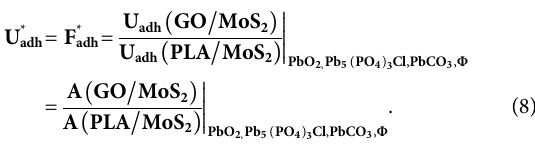
Figure 7 compiles the evolution of U adh* for the “ PbO 2 , Pb 5 (PO 4 ) 3 Cl, and PbCO 3 ” adsorbate as function of the refractive index ratio n * = n (GO/MoS 2 )/ n (PLA/MoS 2 ) for Φ = 0%, 10%, 20%, and